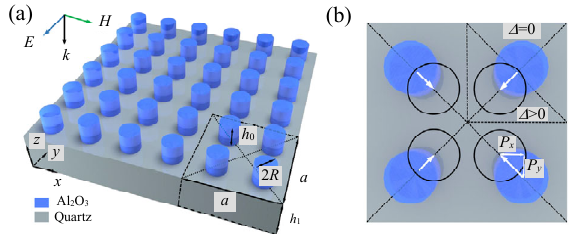
Fig. 1 Schematic of the all-dielectric metasurface structure: (a) 3D schematic of the GHz all-dielectric metasurface structure and (b) top view ( x - y plane) of the unit